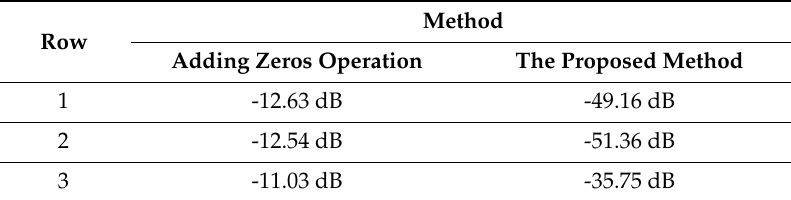
Table 5. Analysis of fake targets in the point target simulation.